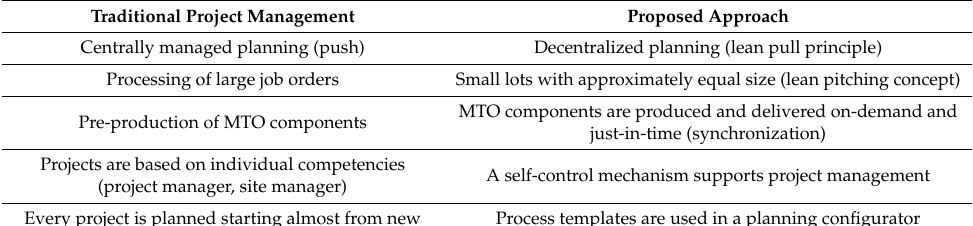
Table 4. Comparison of the traditional and the proposed